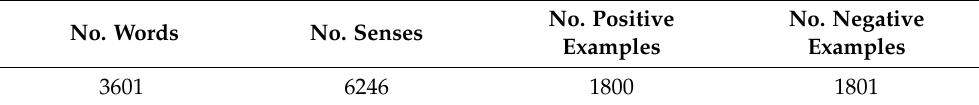
Table 6. Test data statistics.